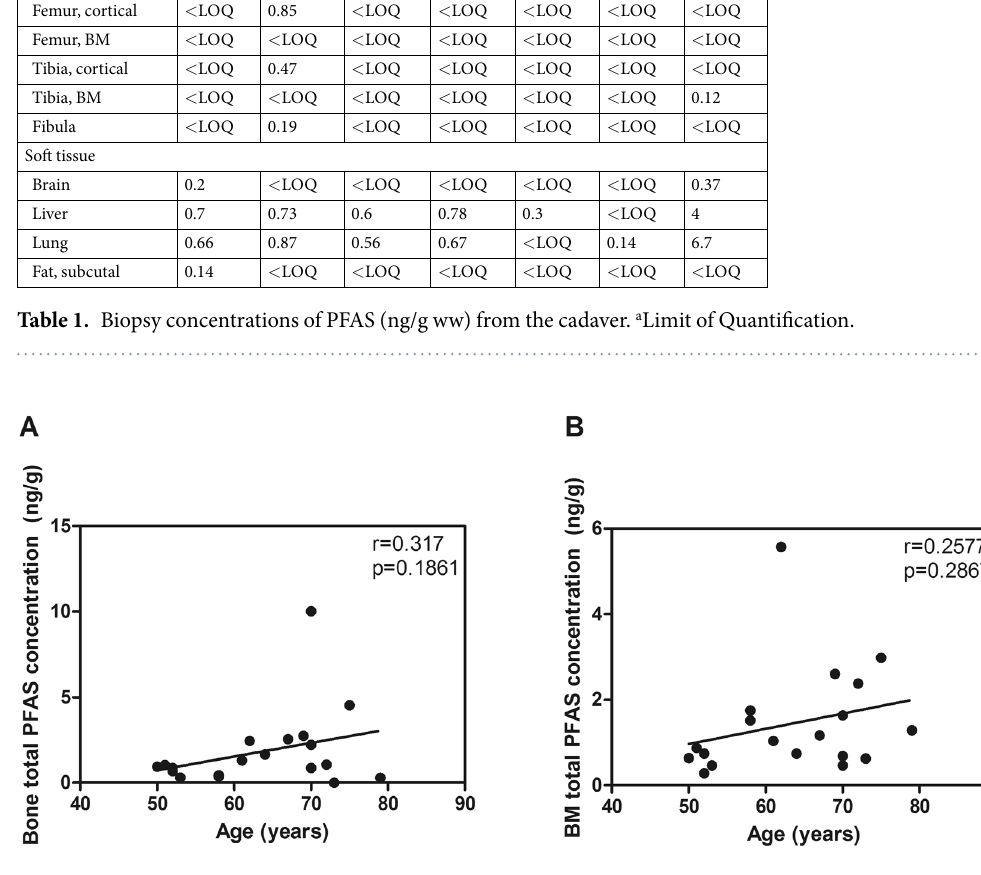
Figure 3. Dependence of age on total concentrations of PFAS in bone ( A ) and bone marrow ( B ).